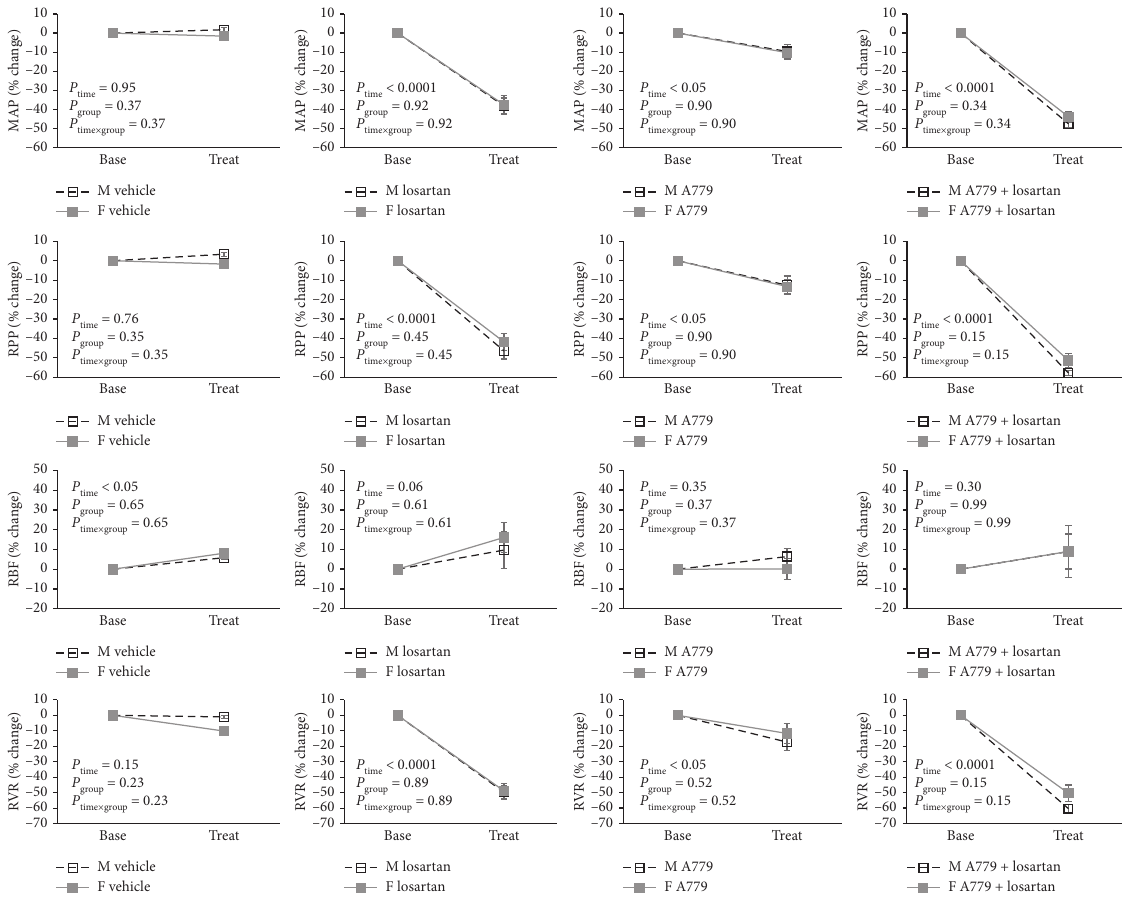
Figure 3: The effect of antagonist on hemodynamics parameters. MAP, RPP, RBF, and RVR stand for mean arterial pressure, renal perfusion pressure, renal blood flow, and renal vascular resistance in male M and female F rats. Data are presented as mean ± SEM and were analyzed using repeated-measures ANOVA with the factors group (sex), treat (antagonist), and their interaction. Table 3: Mean arterial pressure (MAP) in the equilibrium time (base), 30min after antagonist administration (treat), and graded an- giotensin II